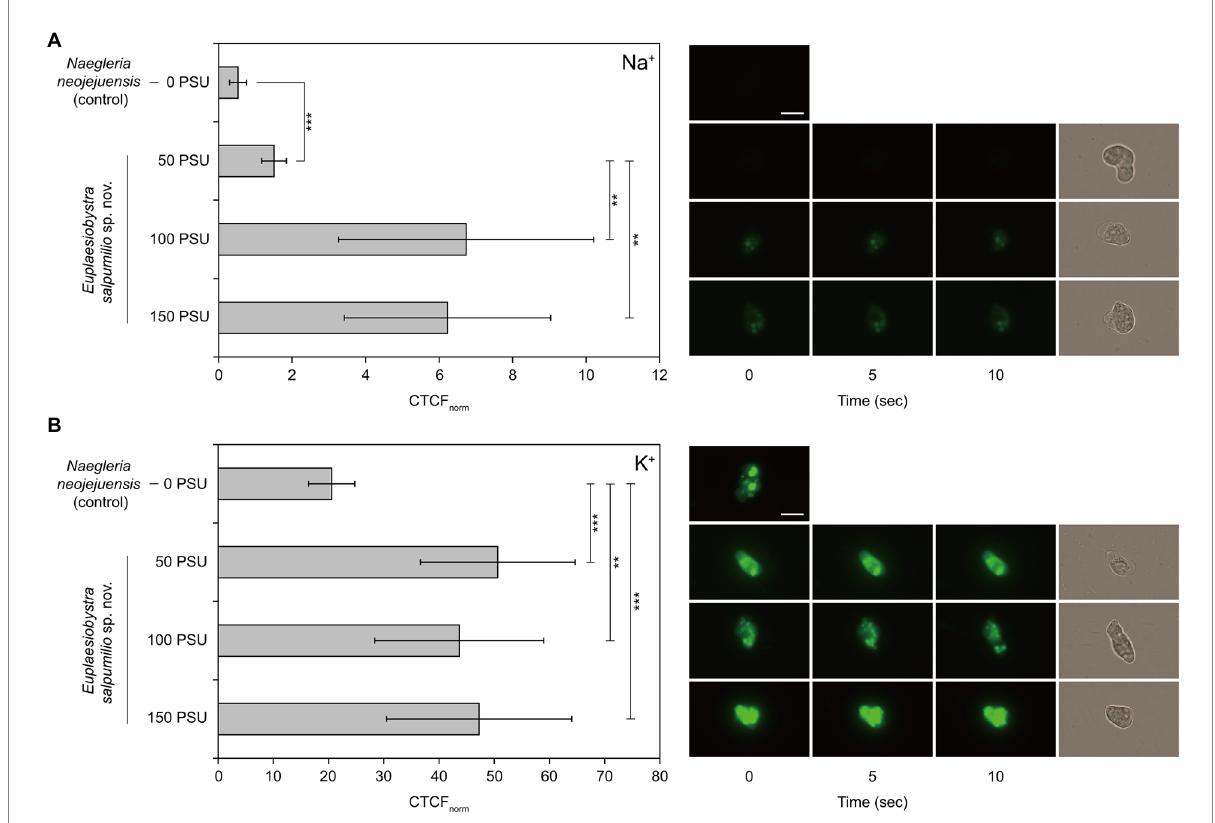
FIGURE 6 Normalized corrected total cell fluorescence of Euplaesiobystra salpumilio sp. nov. with (A) CoroNa Green (for Na + ) and (B) ION Potassium Green (for K + ) at increasing external salinities. The freshwater amoeba Naegleria neojejuensis was used as a negative control (see Khwon and Park, 2018). Note that fluorescence images were taken for 10 s at 5 s intervals, after which a light microscopy image was immediately obtained. Results shown represent the mean ± SD ( n = 10). Data of CoroNa Green and ION Potassium Green were compared using ANOVA with Games–Howell and Turkey’s honestly significant difference analyses, respectively (** p < 0.01; *** p < 0.001). Scale bar: 10 μ m for all microscopy